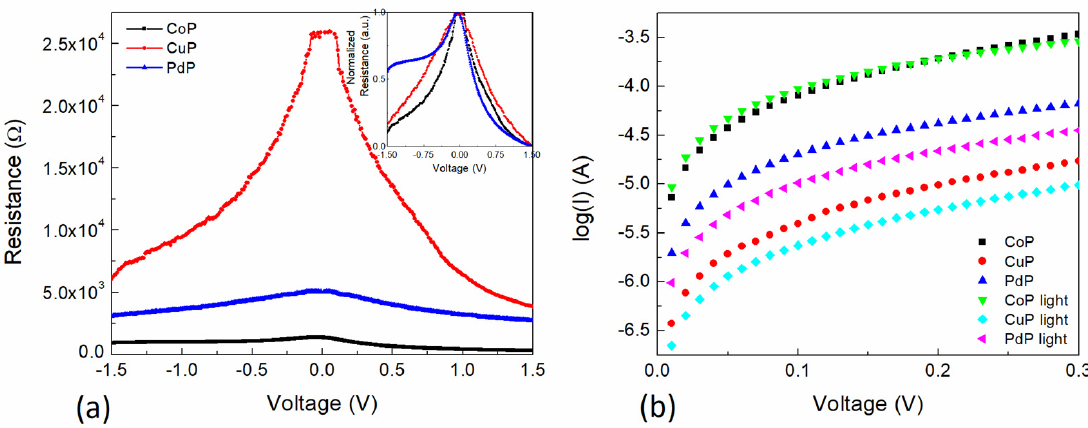
Figure 9. ( a ) Voltage dependent device resistance for the different porphines and ( b ) semilogarithmic I-V curves for the different porphines under darkness and illuminated conditions.